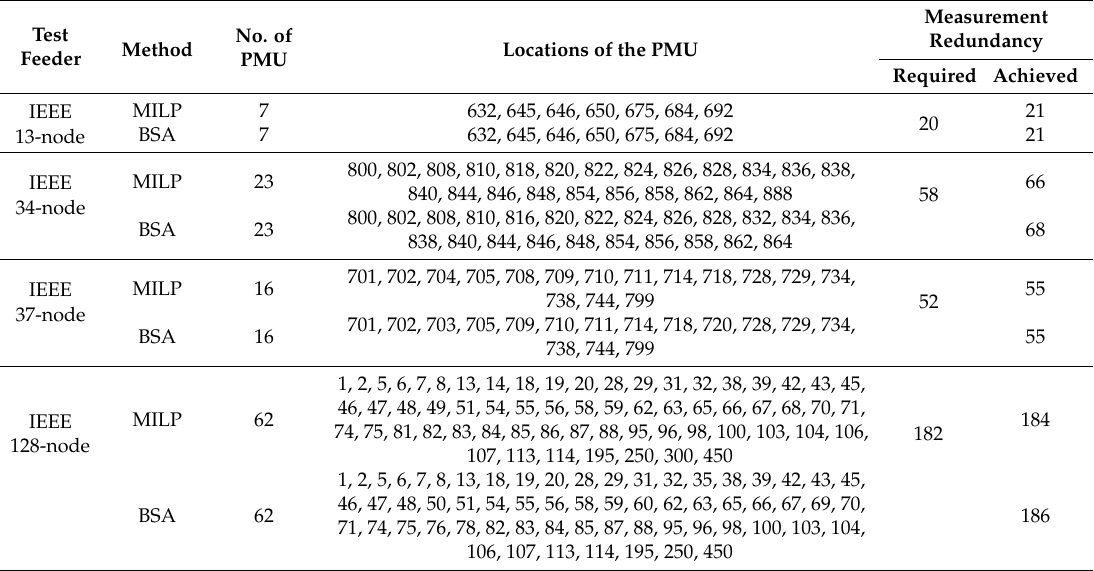
Table 8. Optimal numbers and locations of PMU for different distribution test feeders under single PMU loss case considering ZIB only.